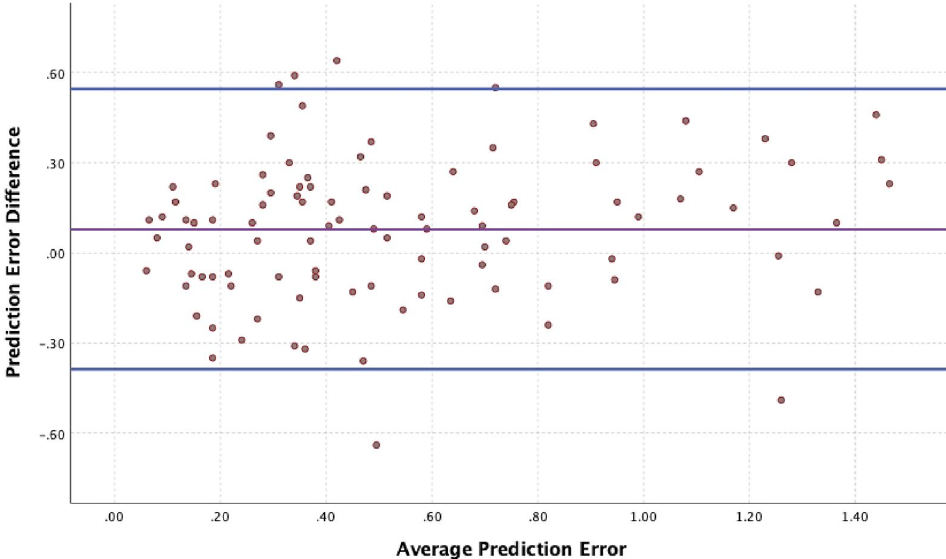
Figure 1. Regression analysis of Bland–Altman plot. Despite statistically significant difference between the preoperative and intraoperative methods in mean prediction error, there is good agreement between them, as demonstrated by the “Intraclass Correlation Coefficient,” Cronbach’s Alpha 0.90.